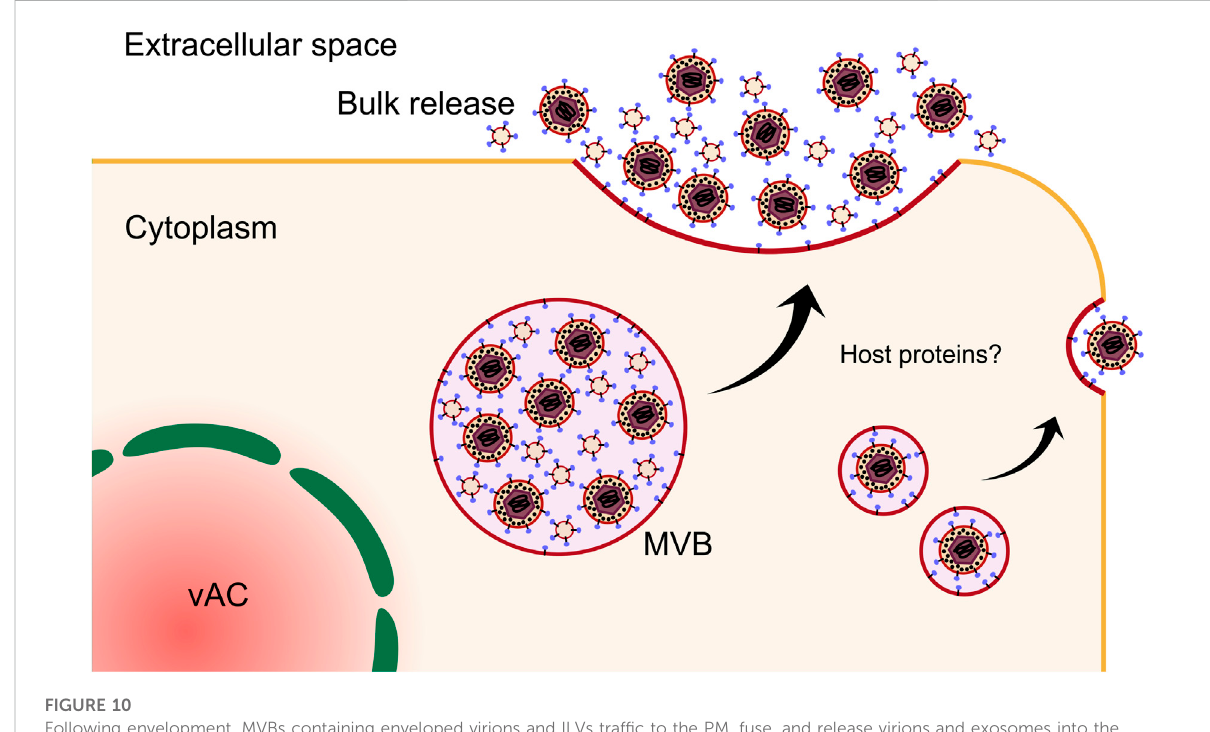
FIGURE 10 Following envelopment, MVBs containing enveloped virions and ILVs traf fi c to the PM, fuse, and release virions and exosomes into the extracellular space through a bulk release mechanism. Simultaneously, virions that undergo envelopment on individual vesicles are thought to fuse directly with the PM to release single virions. Few regulators of virion egress have been characterised to date, however, many host proteins linked to exosome secretion have been associated with viral growth with involvement in egress. Cell type speci fi c divergence, as well as cell-to-cell spread mechanisms, may exist in contrast to the schematic outlined. MVB, multivesicular body; vAC, viral assembly